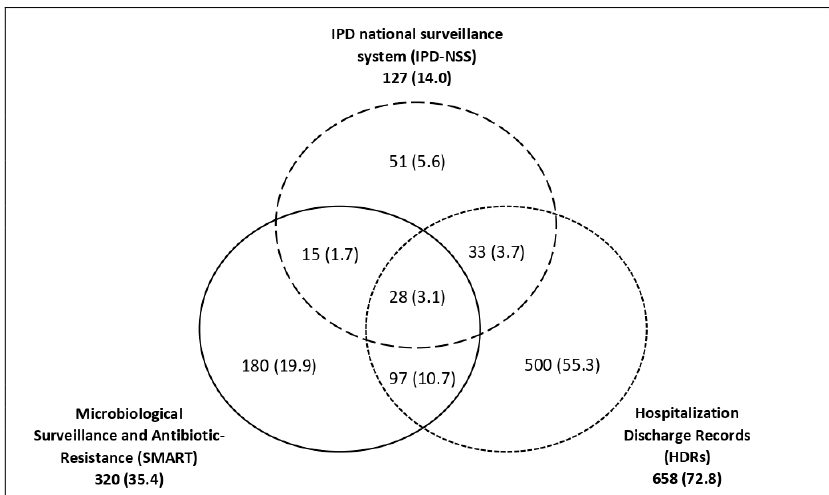
Figure 2. Venn diagram showing the number (percentage) of cases of invasive pneumococcal disease identified from three sources: the IPD national surveillance system (IPD-NSS), the Microbiological Surveillance and Antibiotic Resistance in Tuscany (SMART), and the regional hospitalization discharge records (HDRs) from 2016 to 2017. In total, 904 single cases are individuated by the three combined systems.